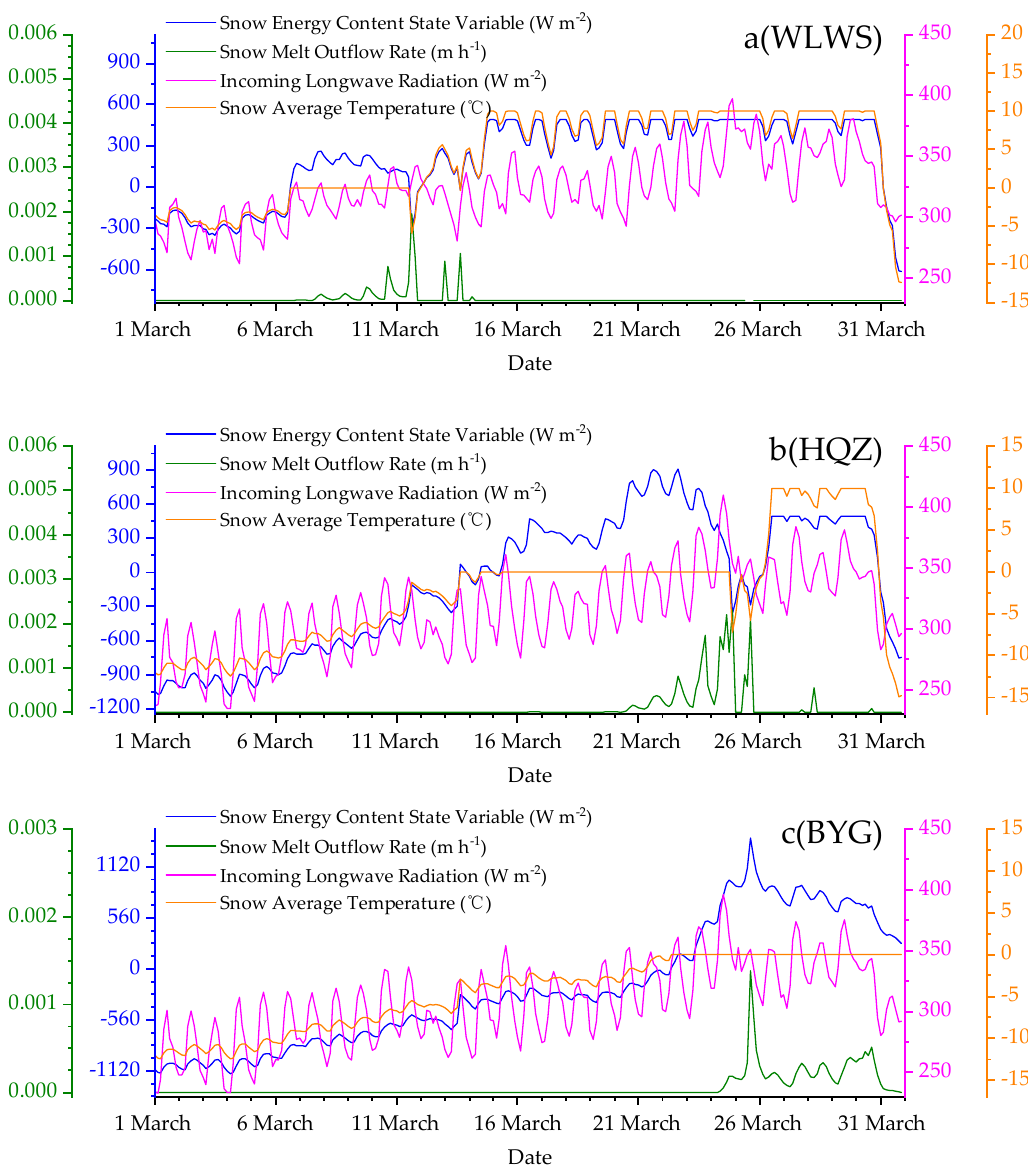
Figure 9. Trends in the simulated snowmelt outflow and related energy items at 3-h intervals between 0:00 on 1 November 2014 and 21:00 on 31 March